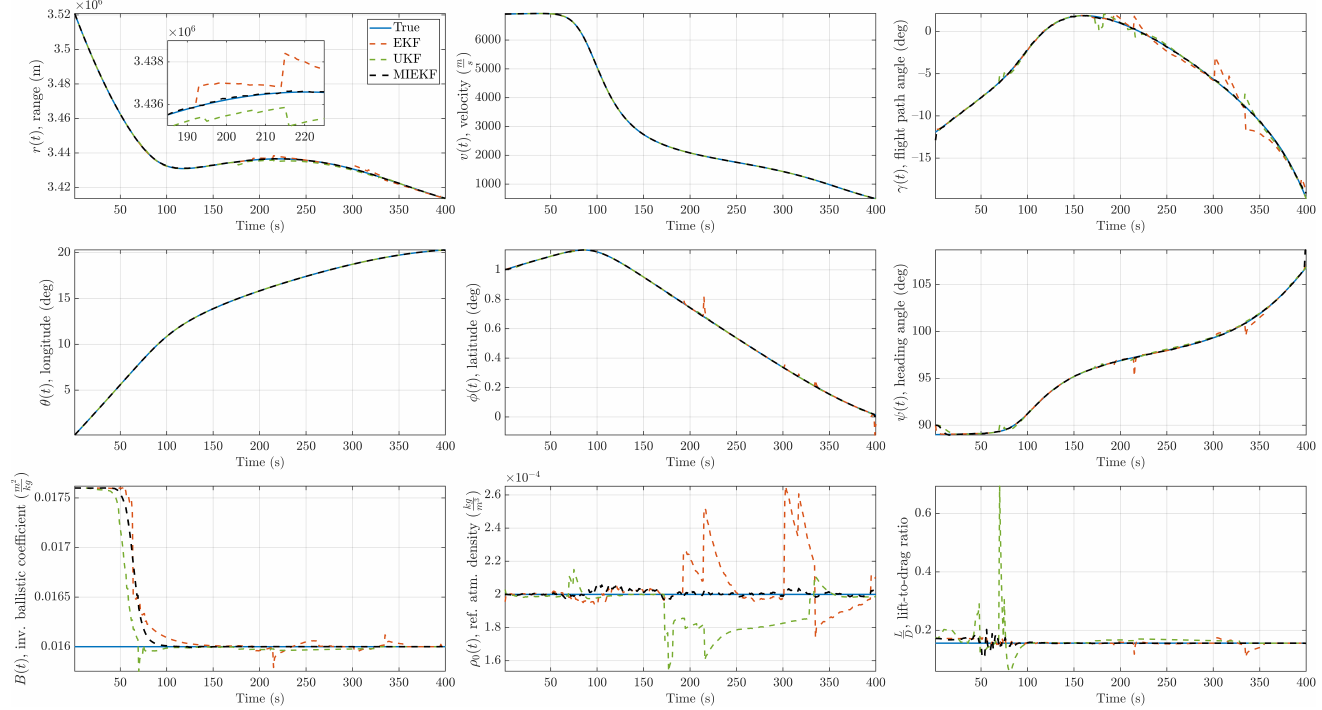
Figure 9. State estimation performance comparison for 5% outlier contamination ( (cid:101) =